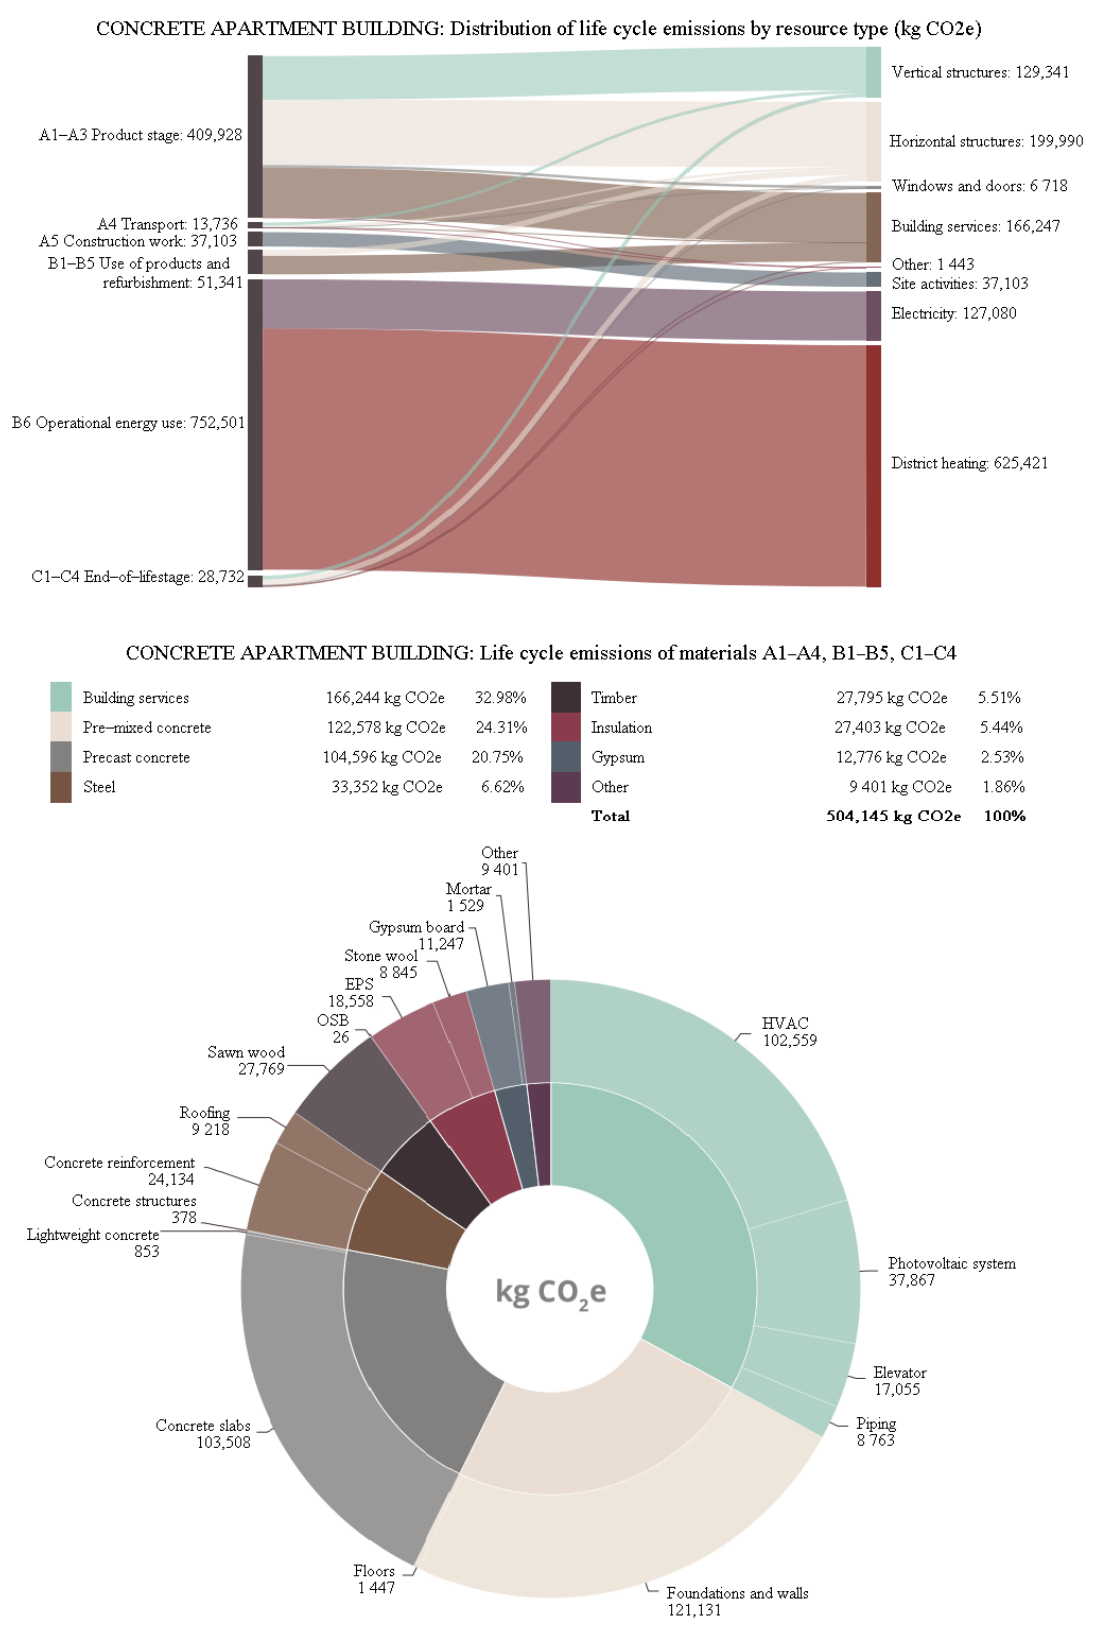
Figure 14. Distribution of the carbon footprint of the concrete apartment building.